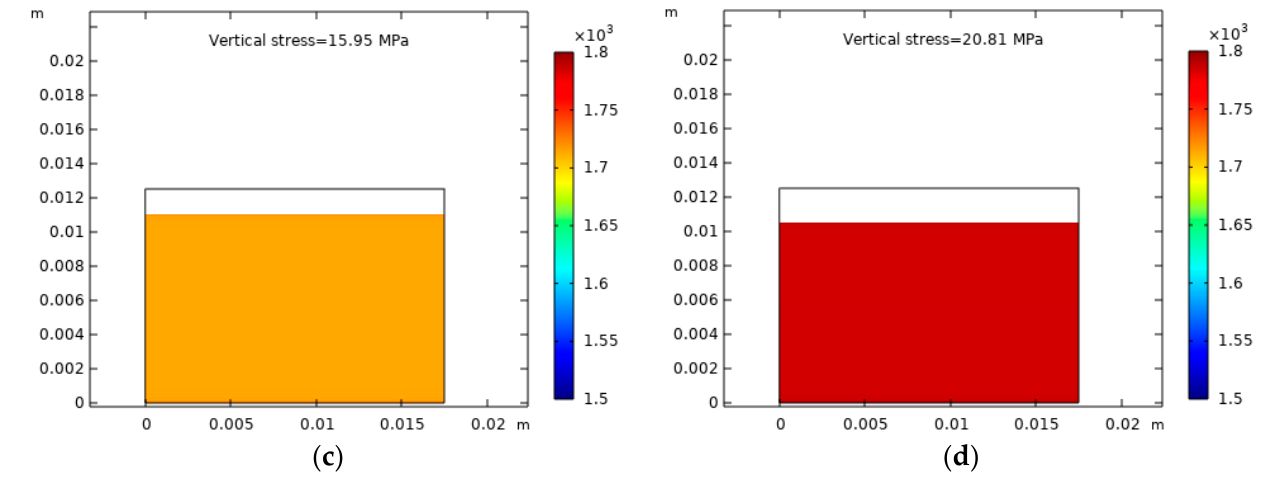
Figure 11. Dry density distribution at different vertical stress ( a ) σ V = 0.02 MPa, ( b ) σ V = 7.97 MPa, ( c ) σ V = 15.97 MPa, ( d ) σ V = 20.81 MPa) (Path ABCD, compression stage BCD).